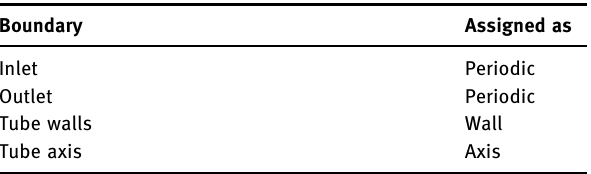
Table 2: Di ff erent boundary conditions used in the applied